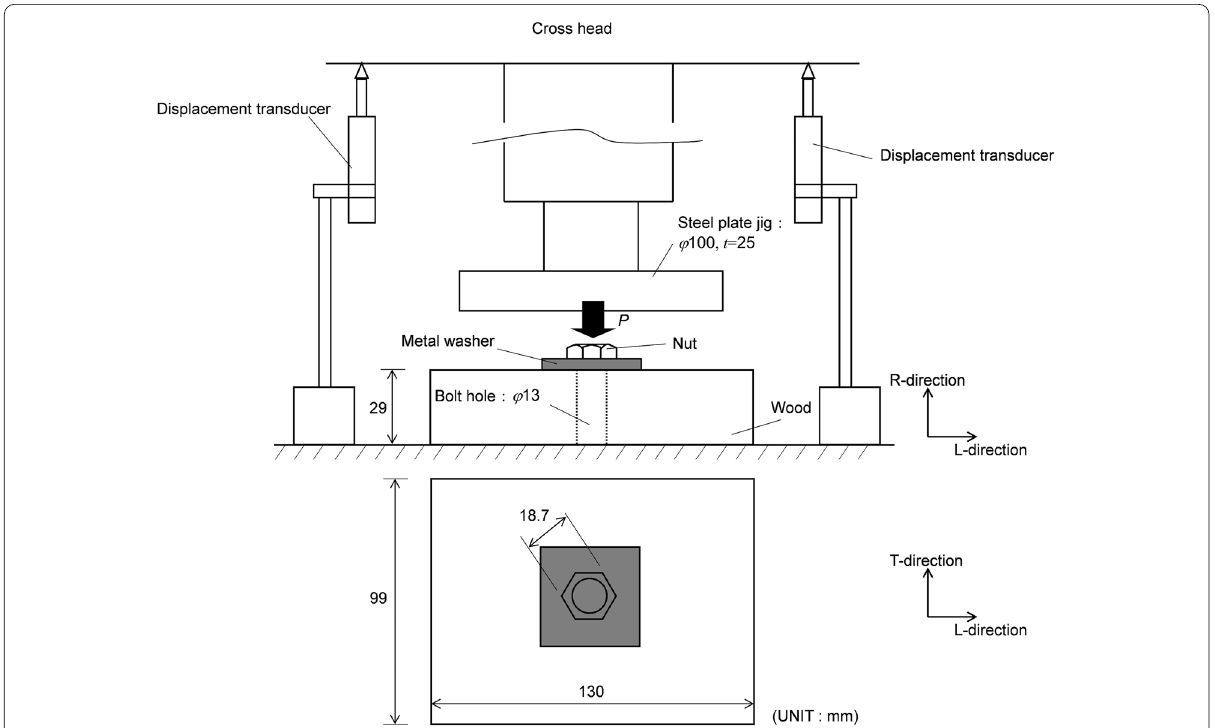
Fig. 1 Schematic of apparatus for embedment test (L: longitudinal, T: tangential, R: